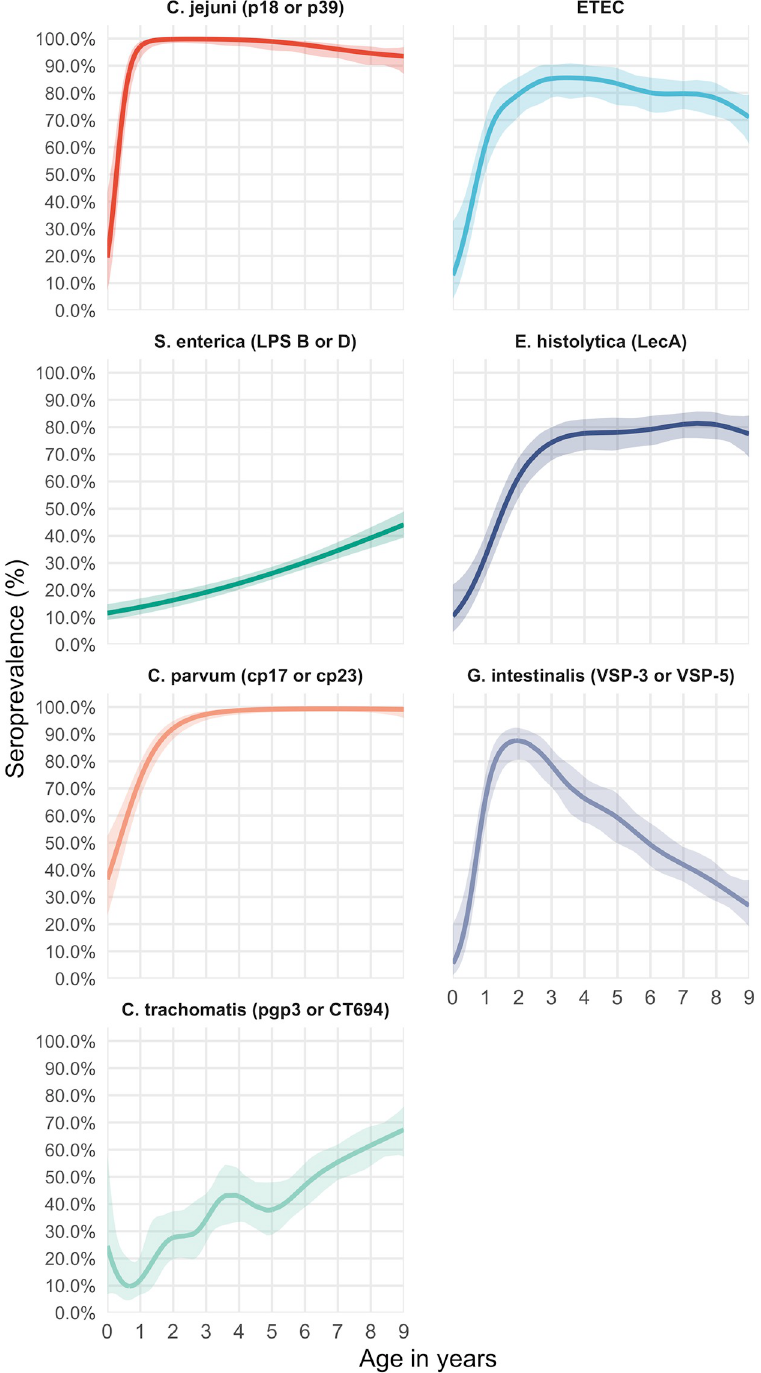
Fig 1. Age-dependent seroprevalence of trachoma and enteropathogens in the Amhara region of Ethiopia. Age- dependent seroprevalence curves were fitted using generalized additive models (GAM) with a cubic spline for age. Seropositivity cutoffs were derived using ROC curves, if available, or by fitting finite mixture models (S1 Fig). Seropositivity cutoffs could not be estimated for V. cholerae in this study, so seroprevalence curves are not shown. For pathogens with more than one antigen, positivity to either antigen was considered positive. IgG response measured in multiplex using median fluorescence units minus background (MFI-bg) on the Luminex platform on 2267 blood samples from 2267